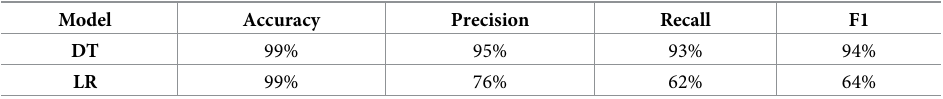
Table 3. Performance of testing on original dataset.